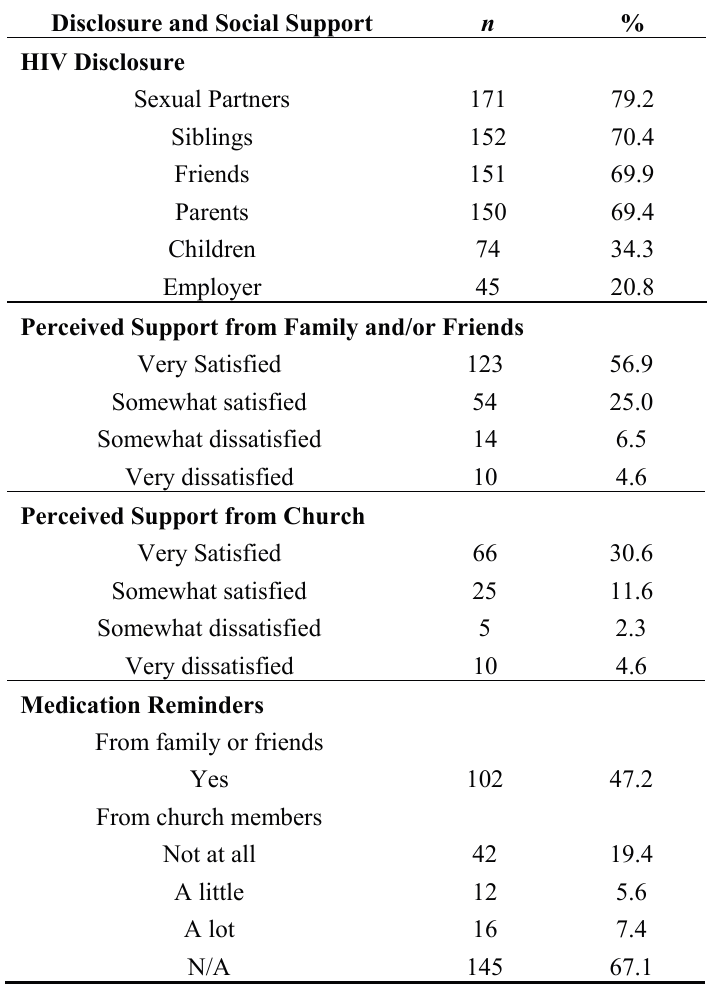
Table 3. HIV Disclosure and Perceived Social Support among Respondents who Received ARVs within the Past 12 Months ( n = 216).